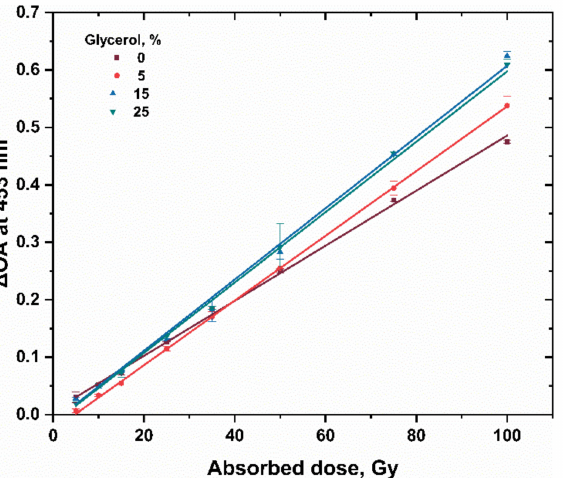
Figure 5. Dose–response curve of PAC hydrogel dosimeter (2% PAC) at different glycerol content, %; net absorbance change at 453 nm as a function of absorbed dose (5–100 Gy for 0, 5, 15, and 15% of